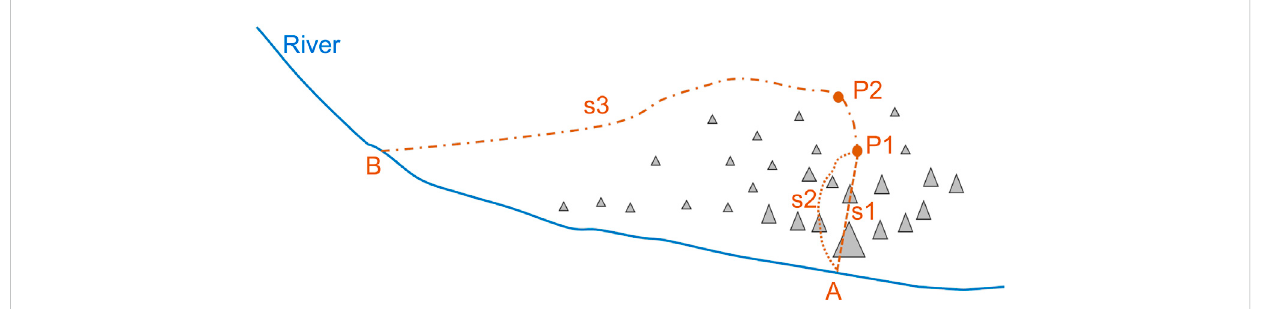
FIGURE 1 Difference between water source distance and irrigation water accessibility.